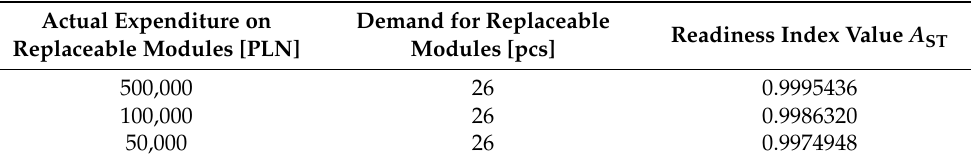
Table 4. List of the number of replaceable modules together with the actual expenditure on replace- able modules needed to ensure an appropriate value of a toll collection station readiness